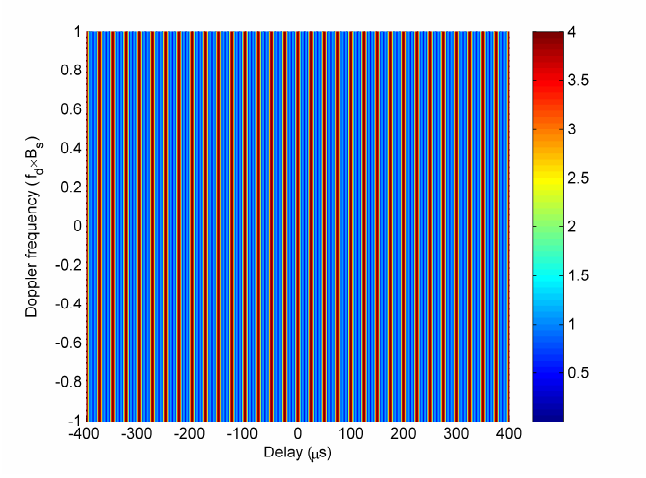
Figure 3. The | W v ( τ , θ ) | for v =